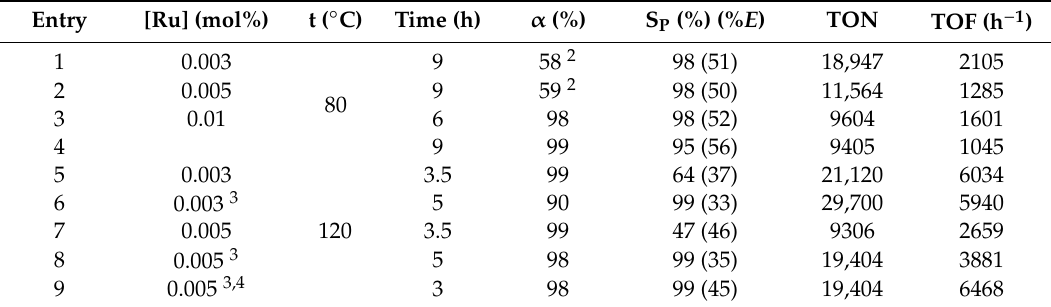
Table 2. The catalytic activity of [RuClH(CO)(PPh 3 ) 3 ] in the presence of 25 ppm of the allyl hydroperoxides from 4-allyloxybutan-1-ol: the e ff ect of the minimal [Ru] loadings 1 .